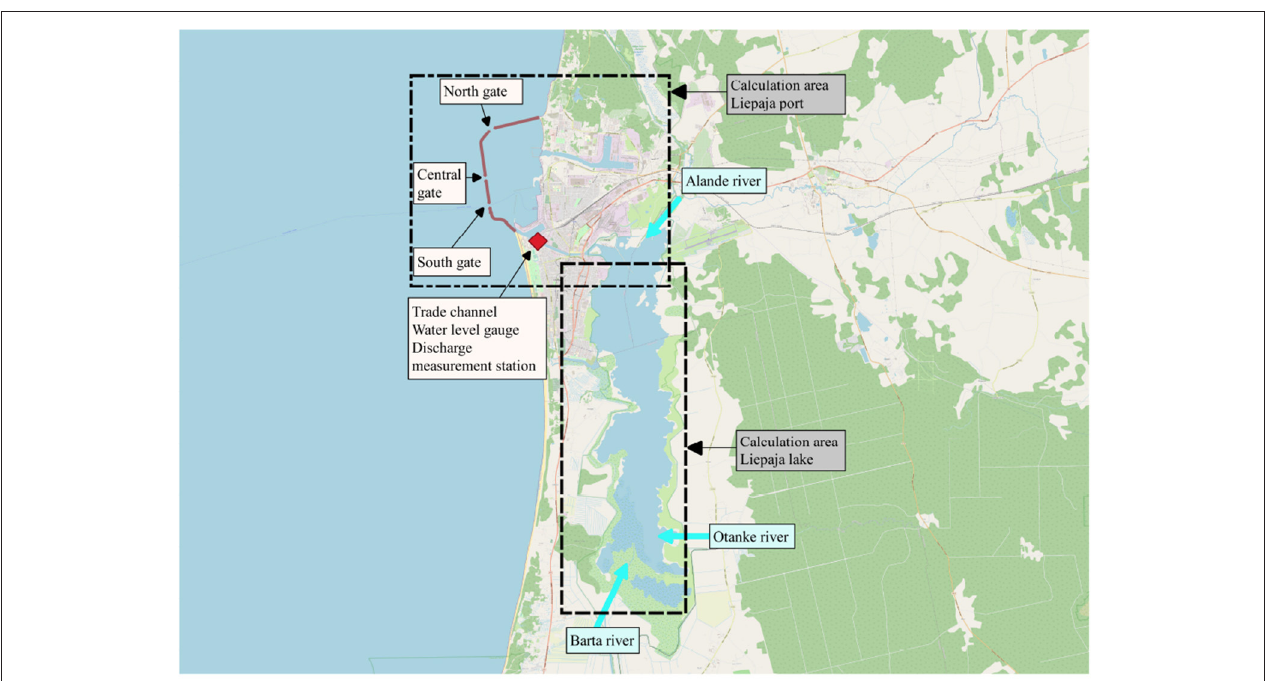
FIGURE 2 | Scheme of Liepaja